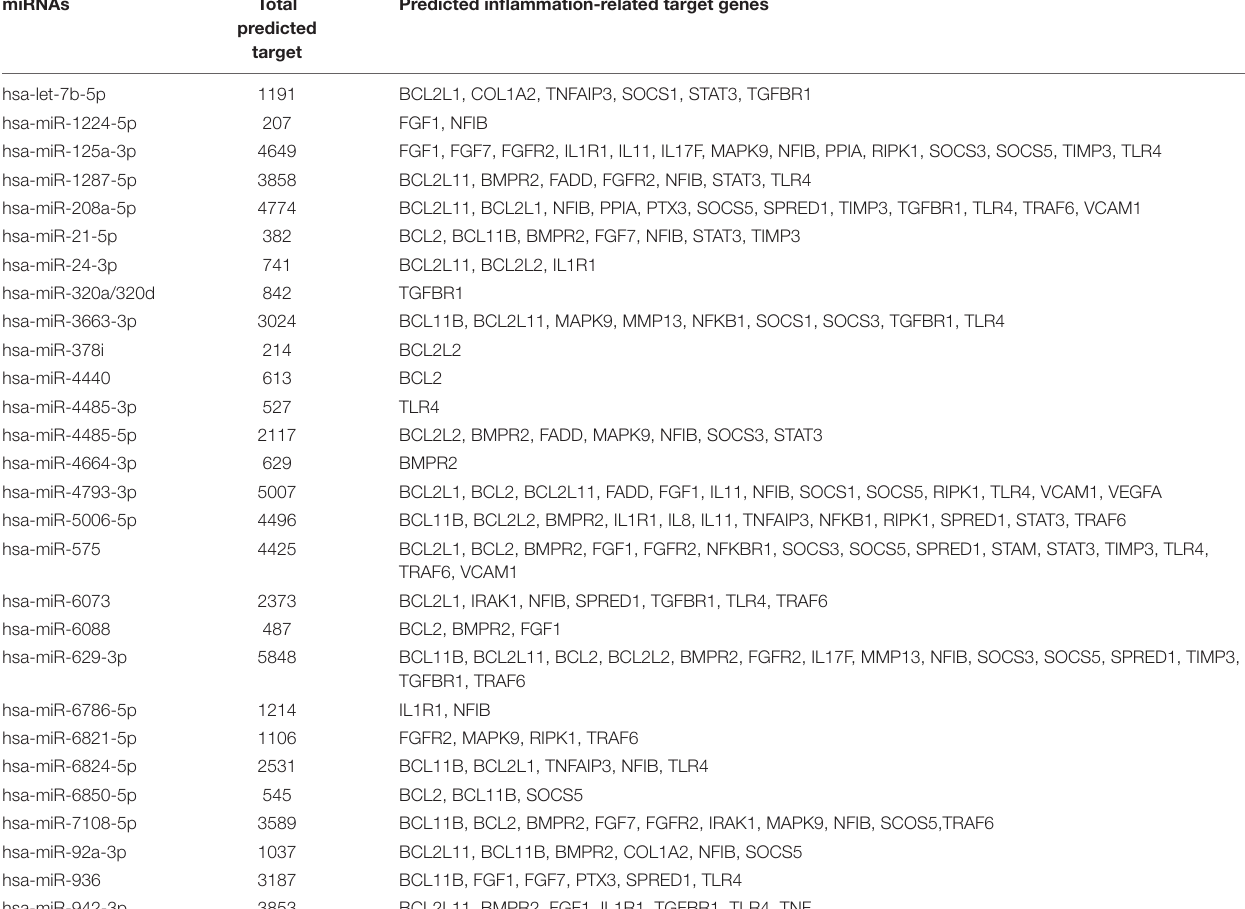
TABLE 3 | Total of all predicted genes (predicted by TargetScan) for top ten (according to FC value) of up- and down-regulated miRNAs in CP plasma- and salivary-exosomal samples. miRNAs Total Predicted inflammation-related target predicted target